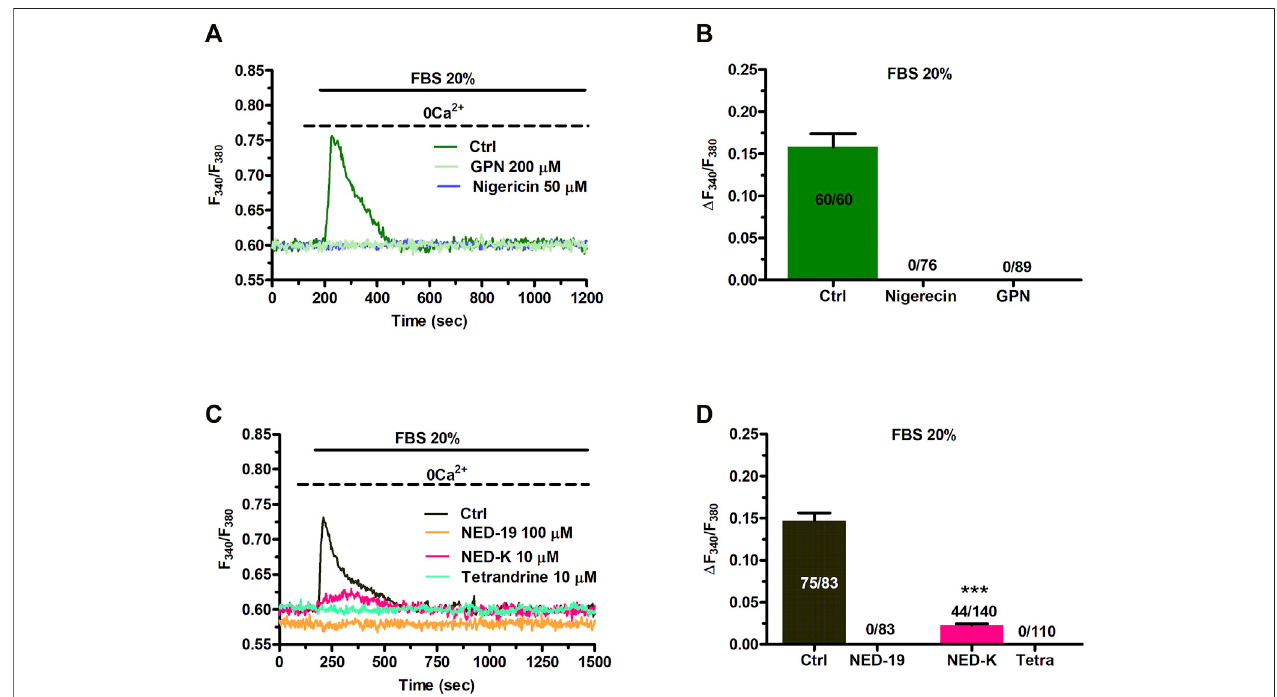
FIGURE 7 | TPCs mediate 20% FBS-induced intracellular Ca 2+ release. (A) Intracellular Ca 2+ release induced by 20% FBS was abolished upon depletion of the lysosomal Ca 2+ pool with either GPN (200 μ M, 30 min) or nigericin (50 μ M, 30 min). (B) Mean ± SE of the amplitude of the intracellular Ca 2+ peak evoked by 20% FBS under the designated treatments. (C) 20% FBS induced an intracellular Ca 2+ transient that was signi fi cantly reduced or inhibited by blocking TPCs with, respectively, NED-K (10 μ M, 30 min), tetrandrine (10 μ M, 30 min) or NED-19 (100 μ M, 30 min). (D) Mean ± SE of the amplitude of the intracellular Ca 2+ peak evoked by 20% FBS in the absence (Ctrl) or presence of NED-19, NED-K or tetrandrine (Tetra). Student ’ s t-test: *** p < 0.001.